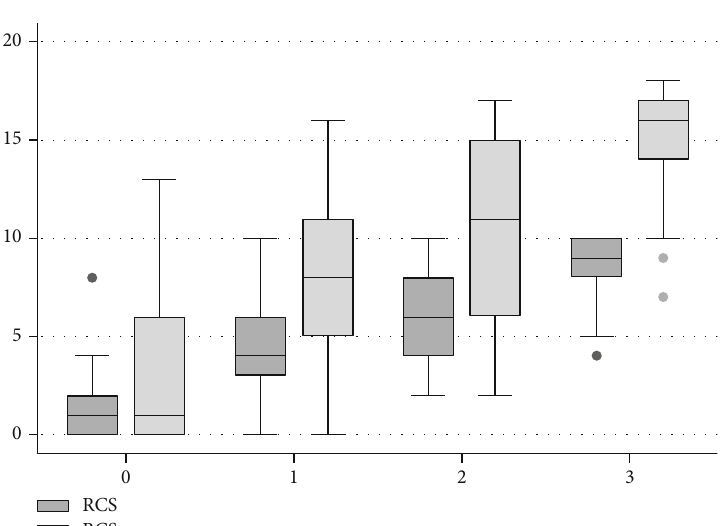
Figure 1: Distribution of the mean scores of the RCS (0-10) and BCS (0-18) ( y -axis) according to the performance on the MCS (0-3) ( x -axis) demonstrating the relation of scores obtained from patients on all the three